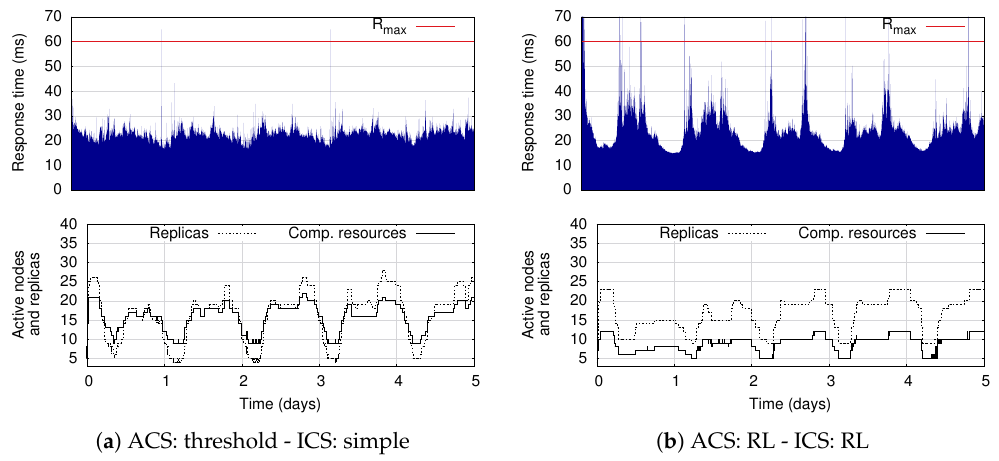
Figure 6. Application response time, number of operator replicas and active computing nodes during the first five simulated days, with and without the RL-based control policies.